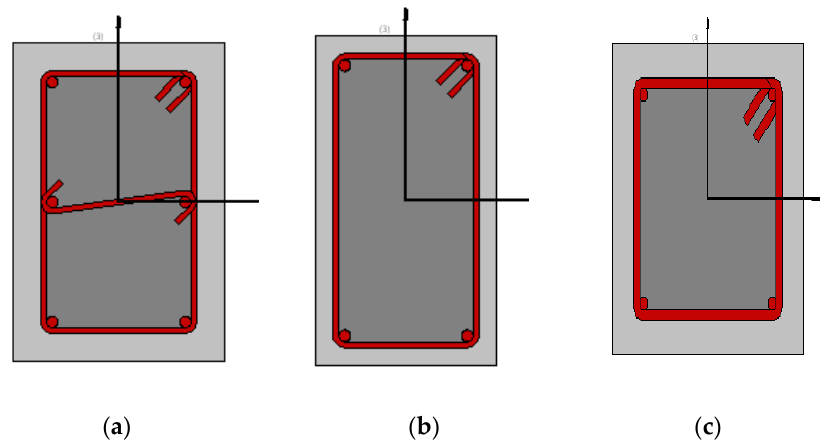
Figure 7. Structural detailing of: ( a ) column; ( b ) beam; and ( c ) lintel beam. Table 3. Dimensions and detailing of the structural members. Structural Member Size (mm) Main Reinforcement All columns of the 4 nos. of 16 mm dia. at a corner and 300 × 450 building two nos. of 16 mm on the longer side